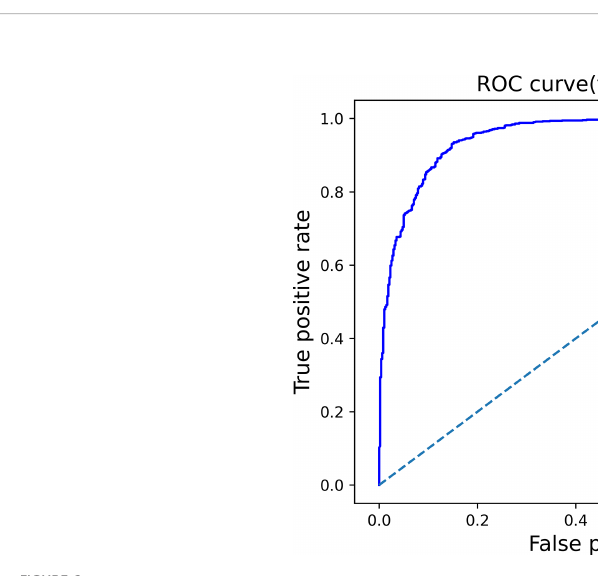
FIGURE 6 ROC curves for benign vs. malignant classi fi cation.